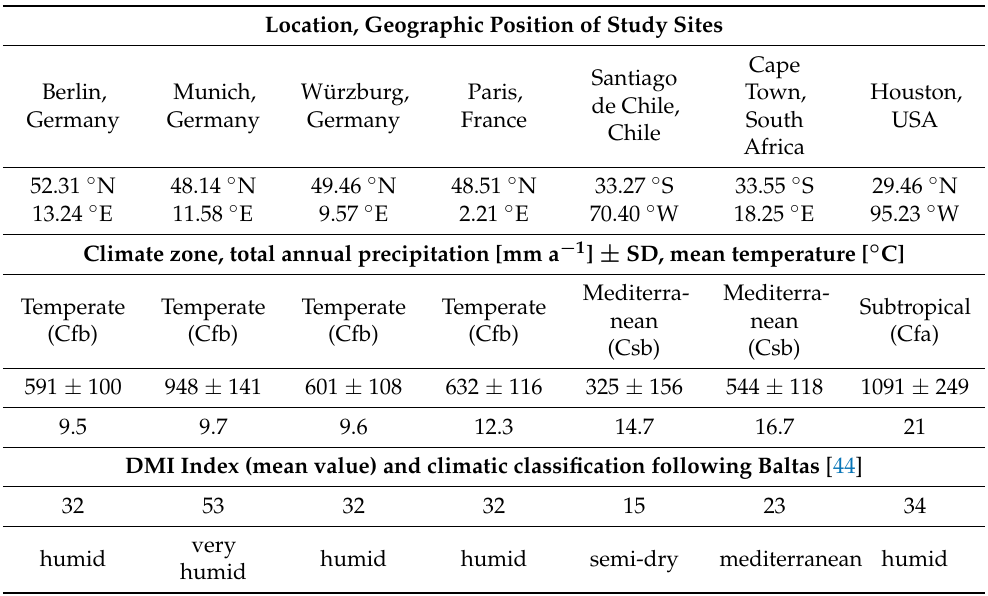
Table 1. Overview of the geographical position and climate conditions (1981–2010) of the study sites. Climate zone refers to the Köppen-Geiger climate classification